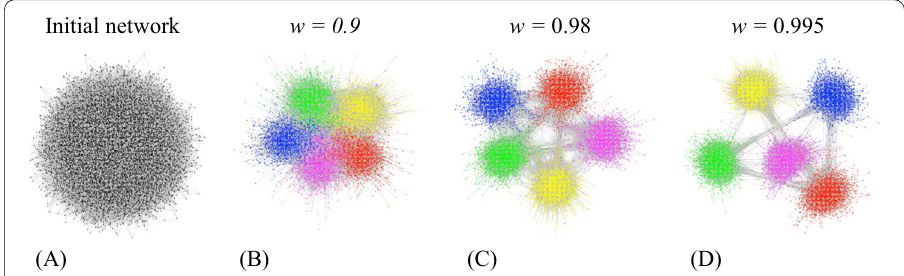
Fig. 2 Visualization of the model for generating scale‑free BA modular networks. The modularity of the network increases from ( A ) to ( D ). A initial non‑modular scale‑free BA network of size N degree (cid:31) k (cid:30) 8. B – D : Illustration of the increasing modularity effect of w on the obtained modular network = divided into m 5 =